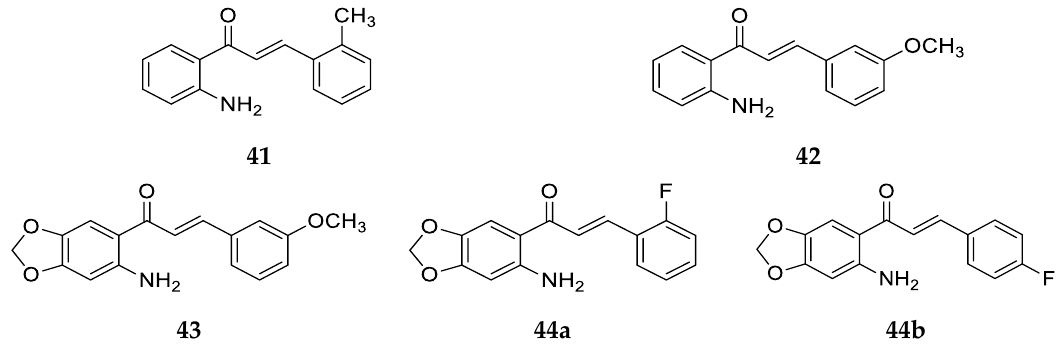
Figure 27. Chemical structures of derivatives of 2-aminochalcone with substitution on rings A and B.